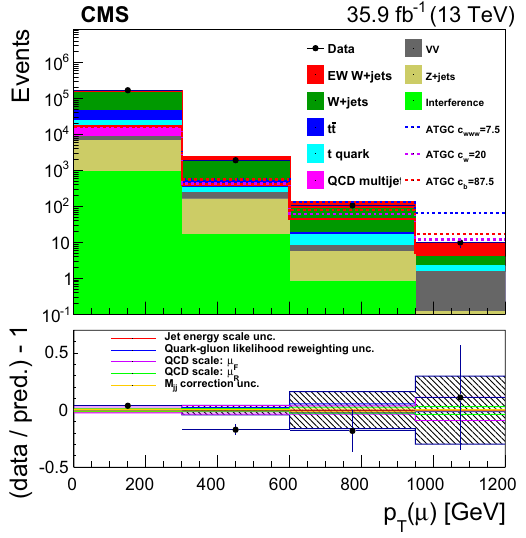
showtheratiobetweendataandpredictionminusonewiththestatistical uncertainty from simulation (grey hatched band) as well as the leading systematic uncertainties in the shape of the p (cid:2)